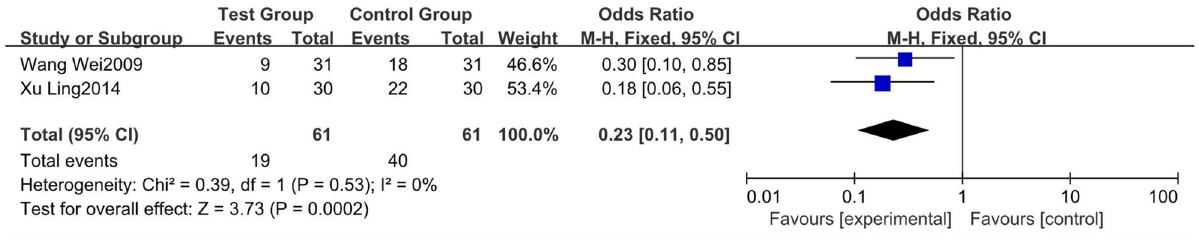
Fig 7. Forest plot of adverse